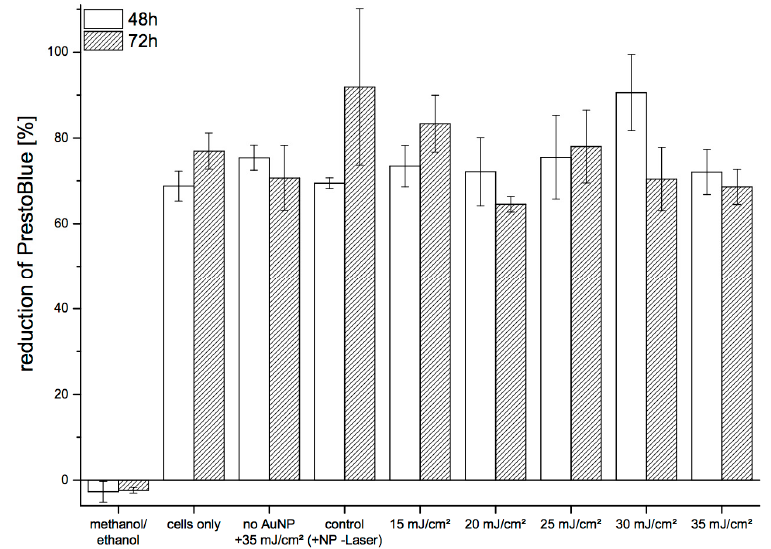
Figure 5. Long-term influence of the experimental procedure on metabolic activity of pHFIB-G measured by the reduction of PrestoBlue 48 h and 72 h after laser irradiation. All values are background-corrected for the blank (cell culture medium only). Means and SE are shown ( n = 3).